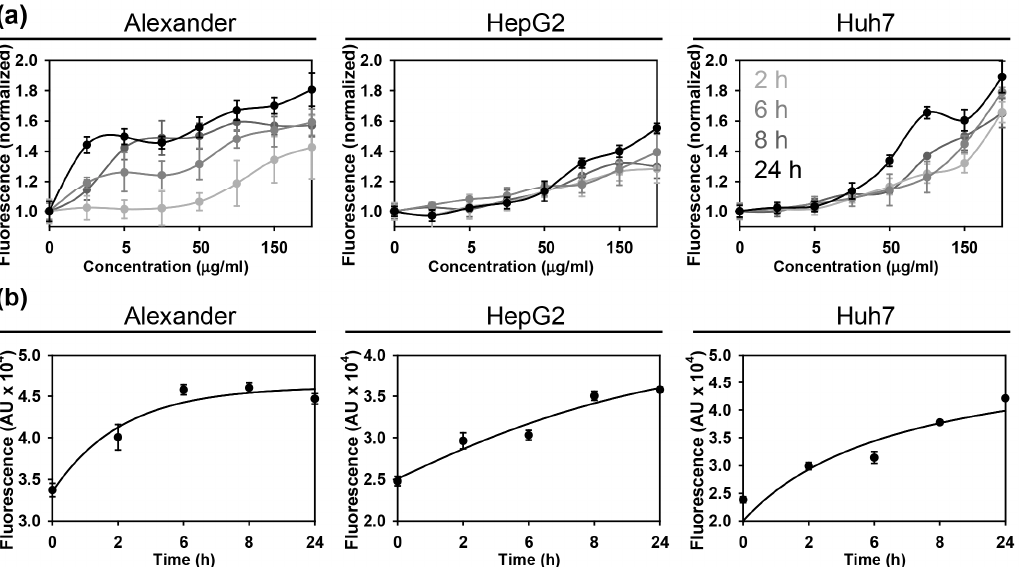
Figure 2. Assessment of the nanoparticle uptake in three distinct hepatic cell lines. Assessment of the uptake kinetics of fluorescently labeled nanoparticles by Huh7, HepG2 and Alexander cells. The fluorescence intensity increase upon nanoparticle treatment was detected by a fluorescent microplate reader. ( a ) depicts concentration-dependent uptake kinetics. ( b ) shows time-dependent uptake kinetics, when cells were treated with NPs 100 µ g Fe mL − 1 for indicated periods of time. The data are expressed as mean ± SEM, n = 4 each.